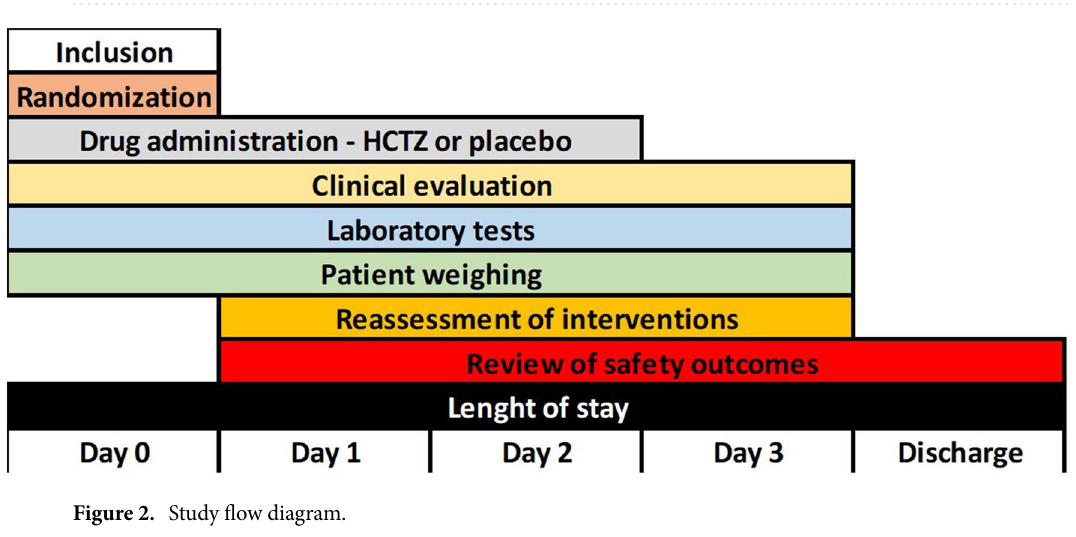
Figure 2. Study flow